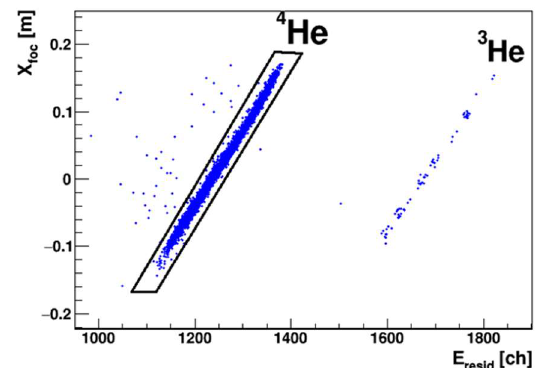
Fig. 4. A θ α versus excitation energy ( E x ) spectrum for the 4 He + 4 He → 4 He + 3 H + 1 H mode. The experimental data points, presented in black, were acquired in a 4 He - 3 H coincidence measurement. Preliminary simulations for the resonant (0 + ) and the non-resonant continuum are presented with the red and green points, respectively, while the simulated events for the transfer are presented with the blue points. See text for more details.